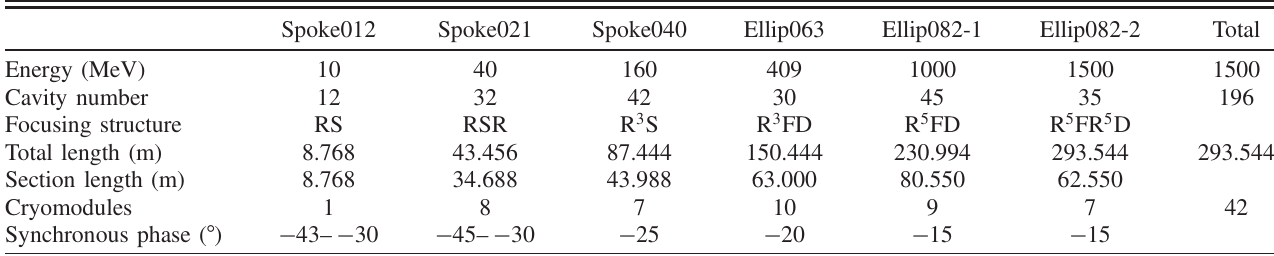
TABLE I. Main parameters of the proton driver